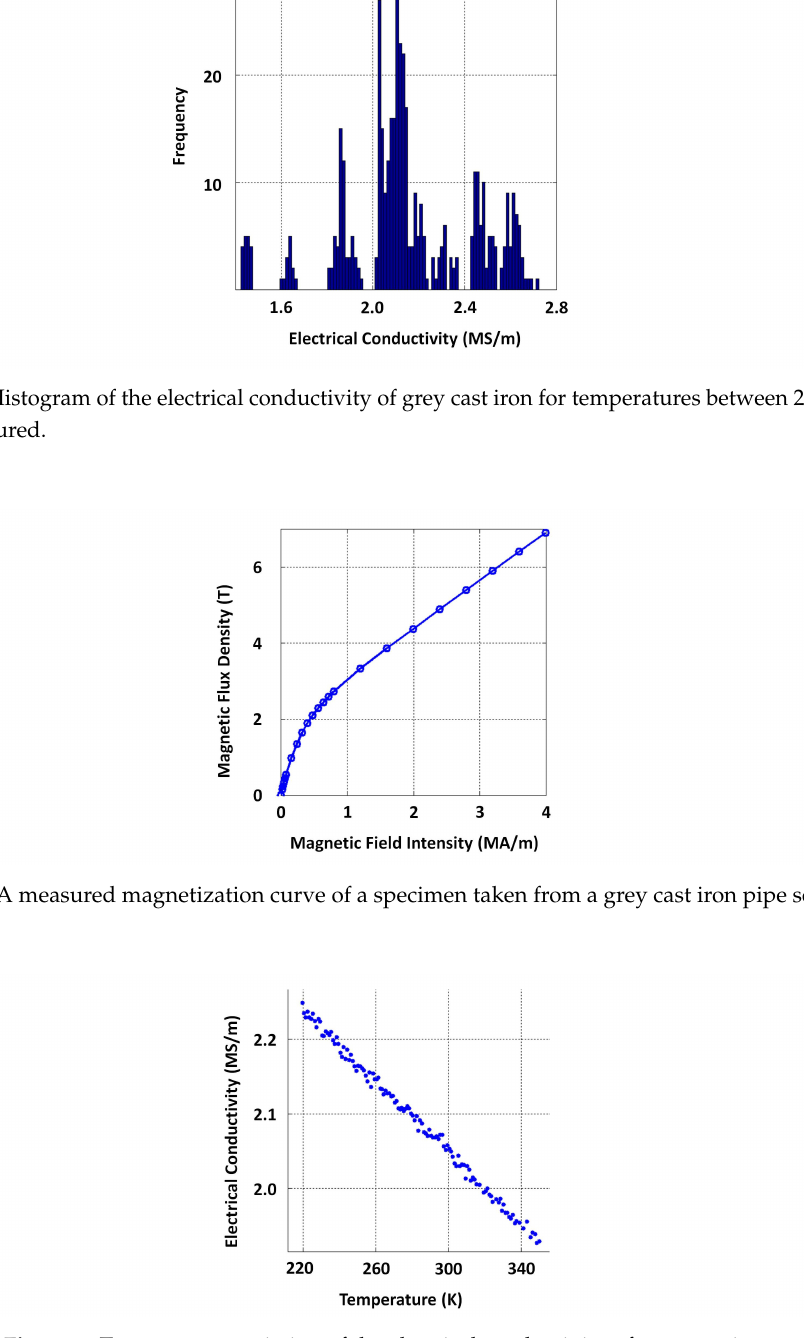
Figure 5. Temperature variation of the electrical conductivity of grey cast